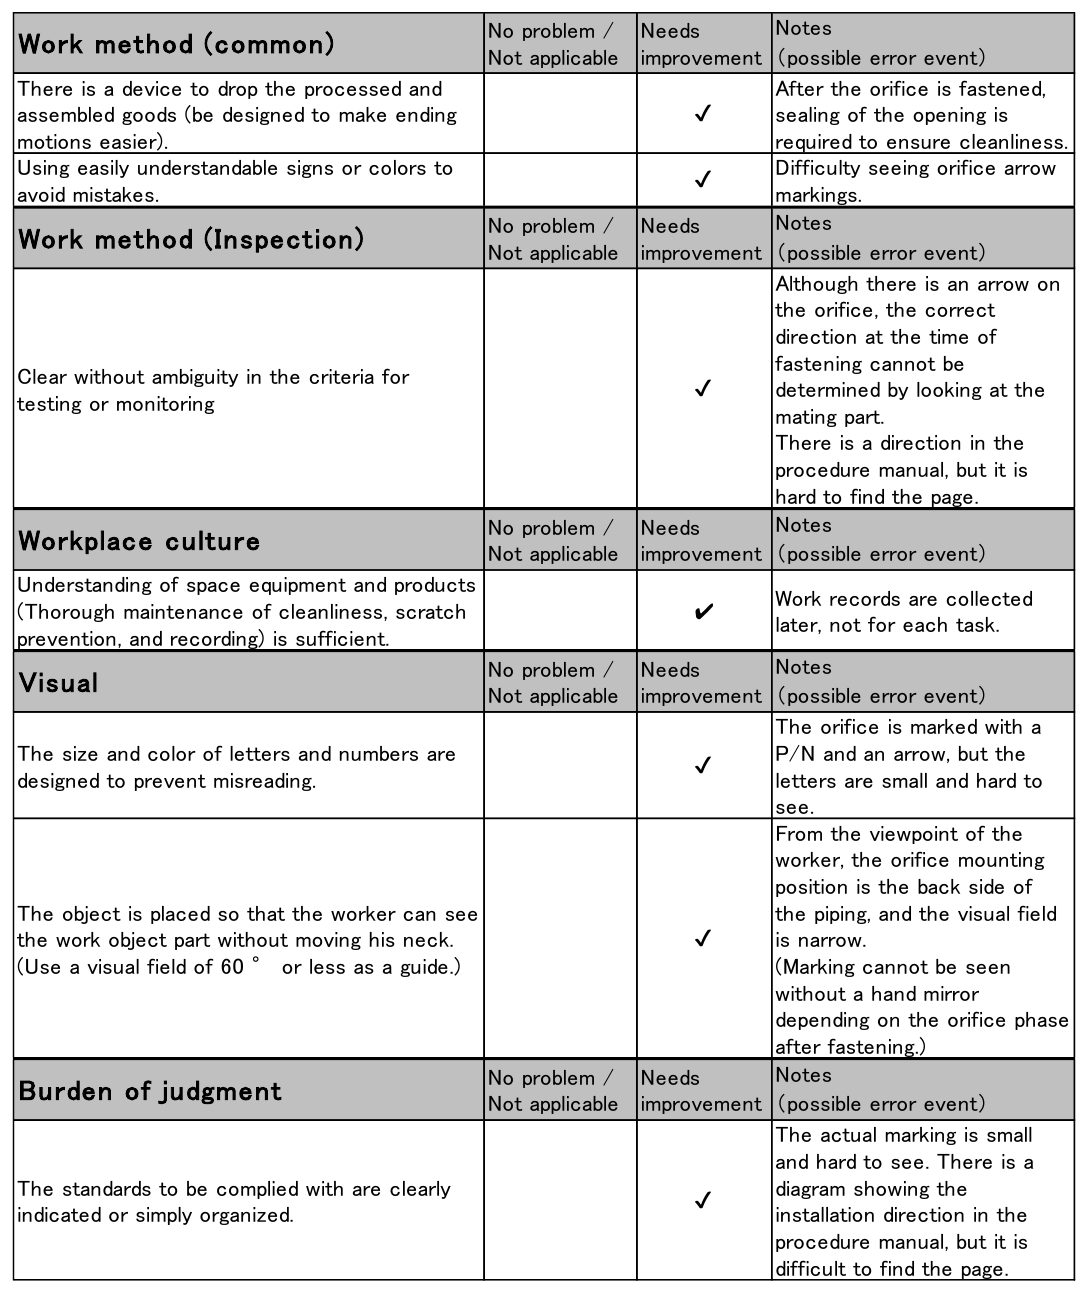
Table 2. Trial result by check sheet